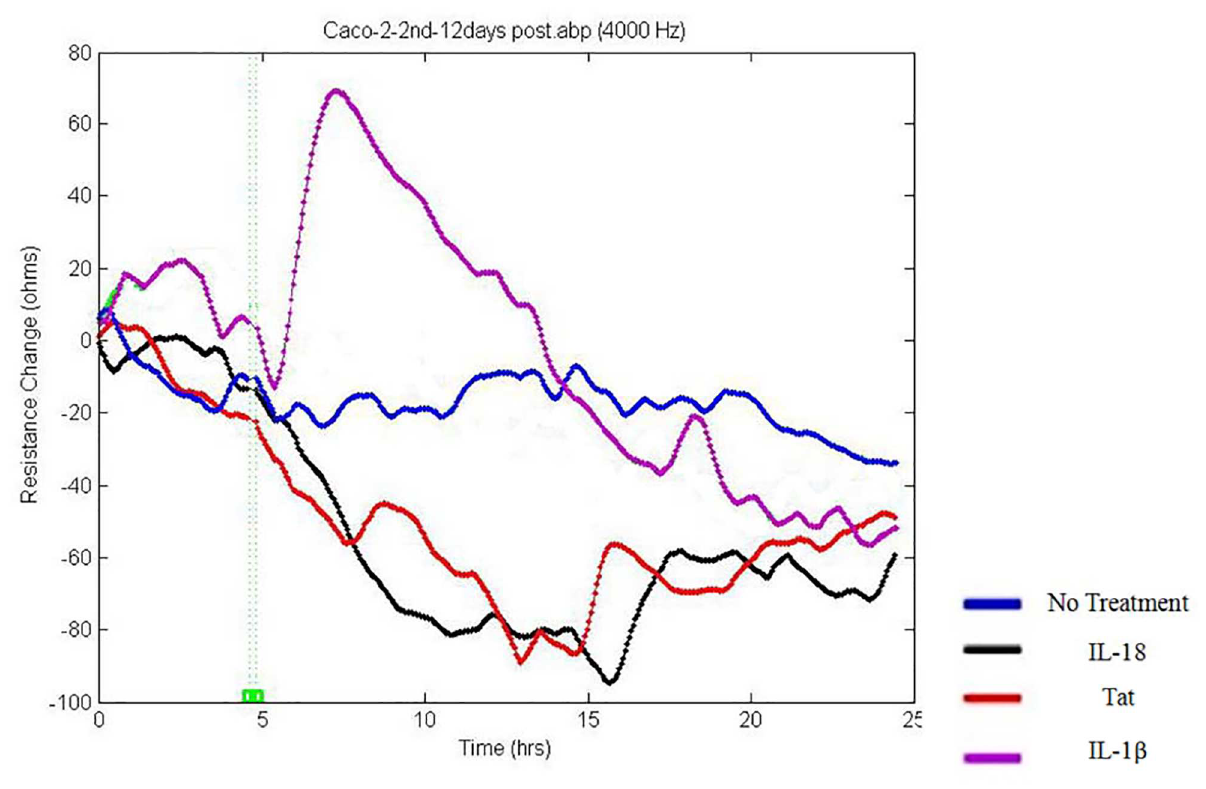
Fig 10. IL-18 decreases TEER in Caco2 monolayers. The TEER was measured during 24 hours after addition of 10 ng/ml of IL-18, 10 ng/ml IL-1 β or 100 ng/ml Tat to the cell monolayers. Note dramatic decrease of the TEER occurring at hour 6 post-exposure by both IL-18 and Tat. IL-1 β causes a transient increase in the TEER followed by a decrease beginning at hour 14 post-exposure. TEER was measured by the Electric Cell-substrate Impedance Sensing ECIS Z θ instrument and 8W10E+ electrode arrays were